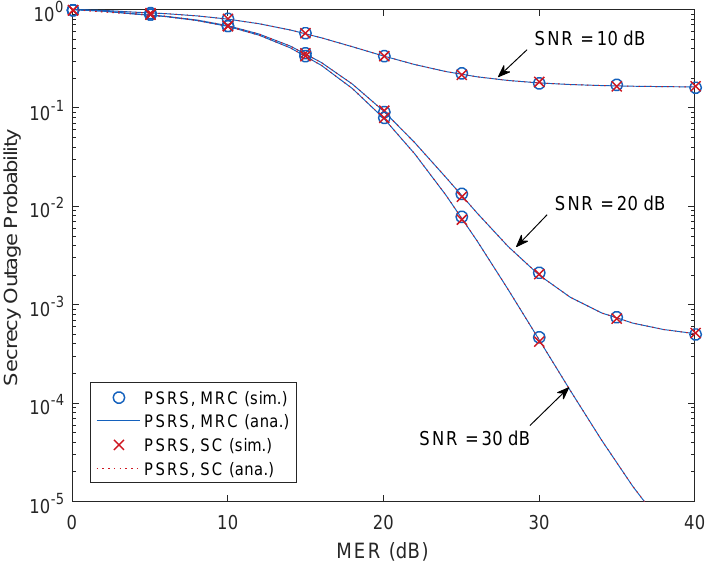
Figure 2. Secrecy outage probability as a function of the main-to-eavesdropper ratio (MER) with different values of the signal-to-noise ratio (SNR), where M = 3, N = 3, d SR = 0.5 and R th = 3 bits/s/Hz.